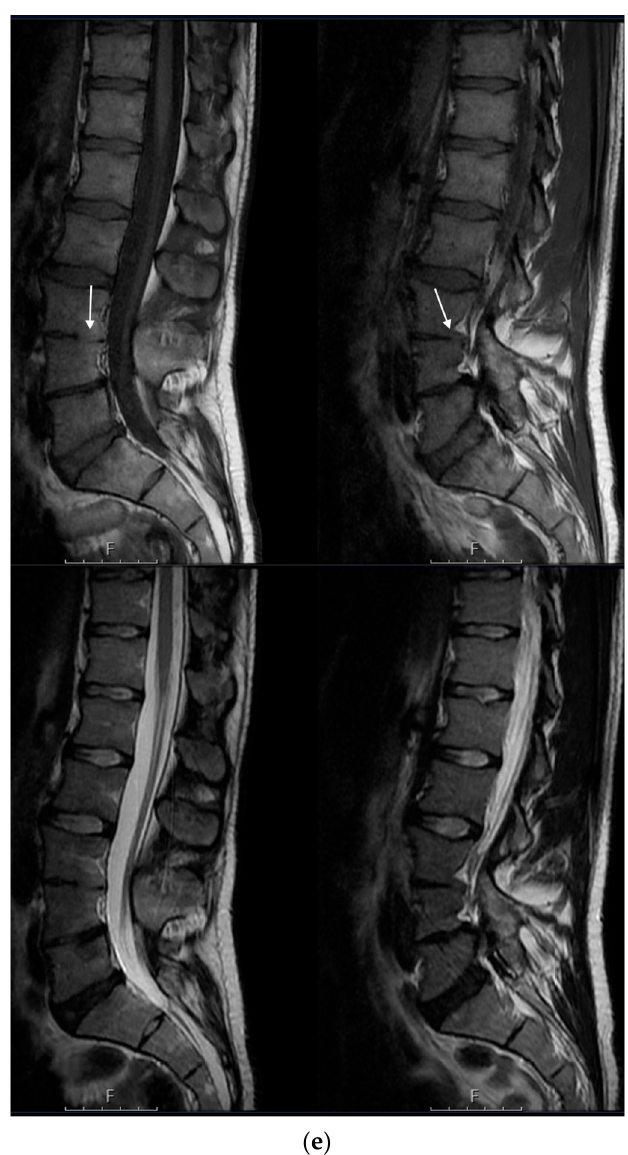
Figure 3. Patient VI.2. ( a ) Photograph of his feet after surgical correction of hallux valgus: note the broad and still valgus deviated halluces and sandal gaps. ( b ) The radiographs of the left elbow showed a dysplastic distal humerus with a tiny trochlea and dysplastic olecranon and a dysplastic convex radial head. ( c ) A computed tomography of the elbow depicted the malformation (upper row: coronal view, lower row: sagittal view). ( d ) Radiographs of the hands displayed a dysplastic first metacarpal base and head, flattening of the heads of metacarpal 3 and 4 as well as synostosis of the middle and distal phalanges of the fifth fingers. ( e ) An MRI of the lumbar spine revealed a partial posterior vertebral synostosis marked by arrows of L3 and L4 (upper row: T1-weighted images, lower row: T2-weighted